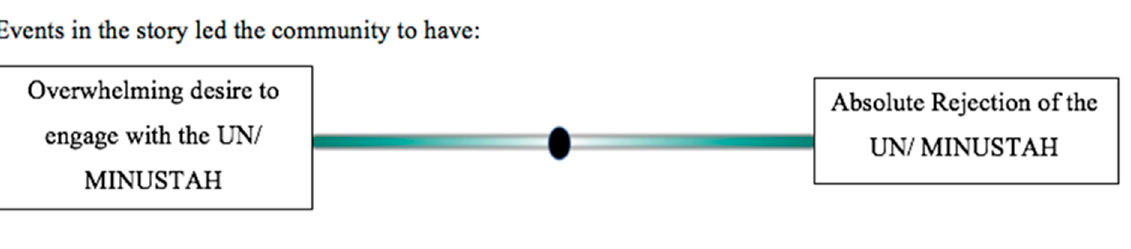
Figure A2. Example dyad question.